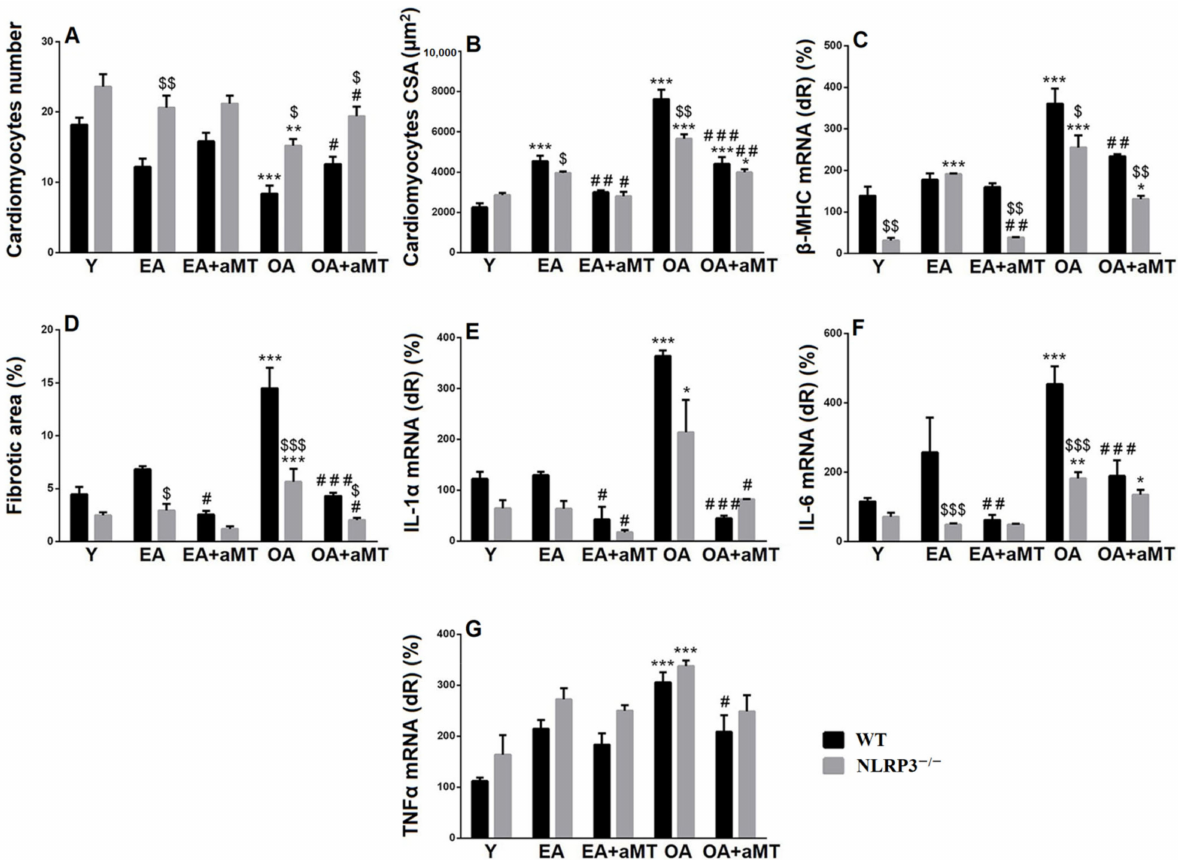
Figure 3. Effect of NLRP3 deletion and melatonin supplementation on age-associated morphometrical changes of cardiac muscle fibers, as well as hypertrophy-associated and inflammatory cytokines genes. ( A , B ) Age-associated morphometrical changes in cardiac muscle fibers number (per 100 µ m 2 ) and cross-sectional area (CSA). ( C ) mRNA expression level of β -MHC. ( D ) Morphometrical analysis of cardiac fibrosis during aging. ( E ) mRNA expression level of IL-1 α . ( F ) mRNA expression level of IL-6. ( G ) mRNA expression level of TNF α * p < 0.05, ** p < 0.01 and *** p < 0.001 vs. Y; # p < 0.05, ## p < 0.01 and ### p < 0.001 vs. aged group without melatonin; $ p < 0.05, $$ p < 0.01 and $$$ p < 0.001 vs. WT